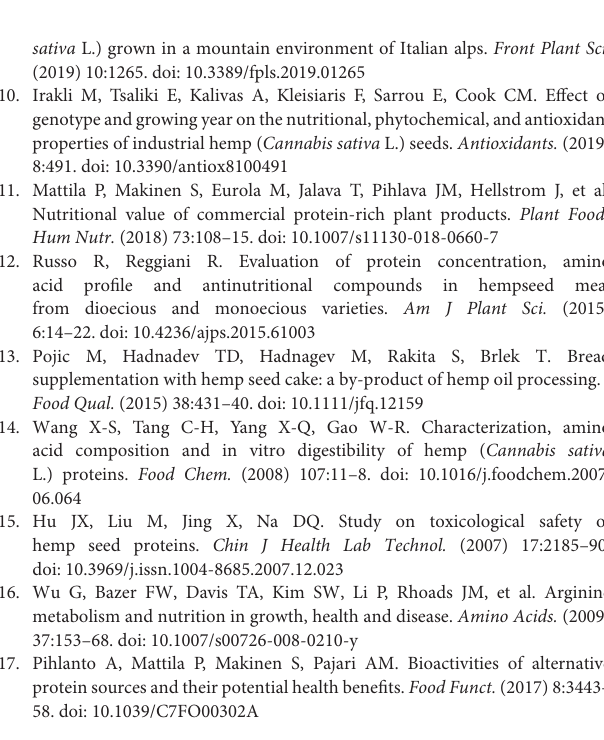
Supplementary Figure 1 | BLAST results of gene coding sequences. Supplementary Figure 2 | Secondary structure and 3D structure model predictions of hemp seed storage proteins. (A) Secondary predictions of the hemp seed storage proteins. (B) Tertiary structure prediction of the hemp seed storage proteins. All the results were predicted by phyre2. Supplementary Table 1 | Primer sequences for cloning genes encoding hemp seed storage